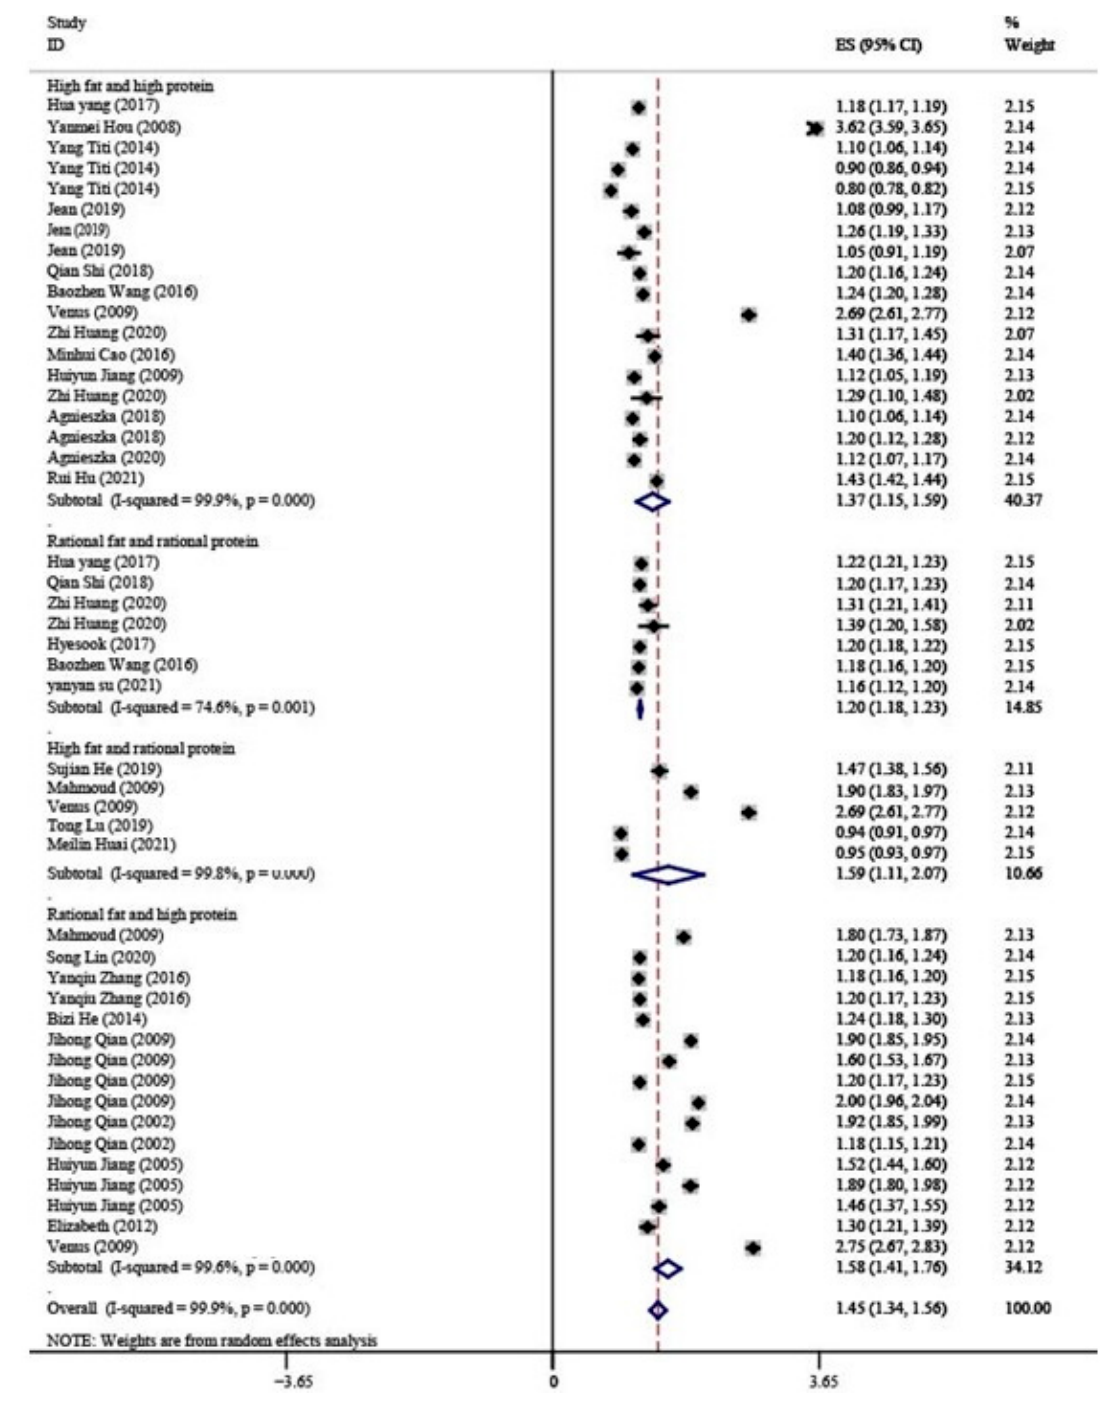
Figure 2. Forest map shows the mean values of protein contents in breast milk at four different dietary patterns [31–61].